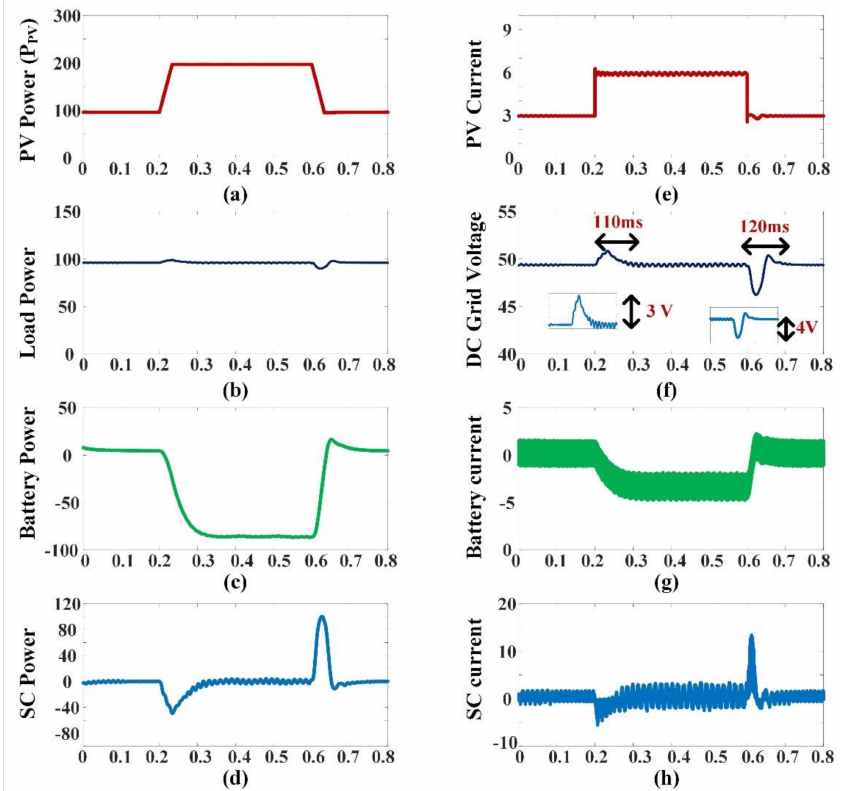
Figure 12. Change in PV generation using a PI control system simulation. ( a ) PV power, ( b )